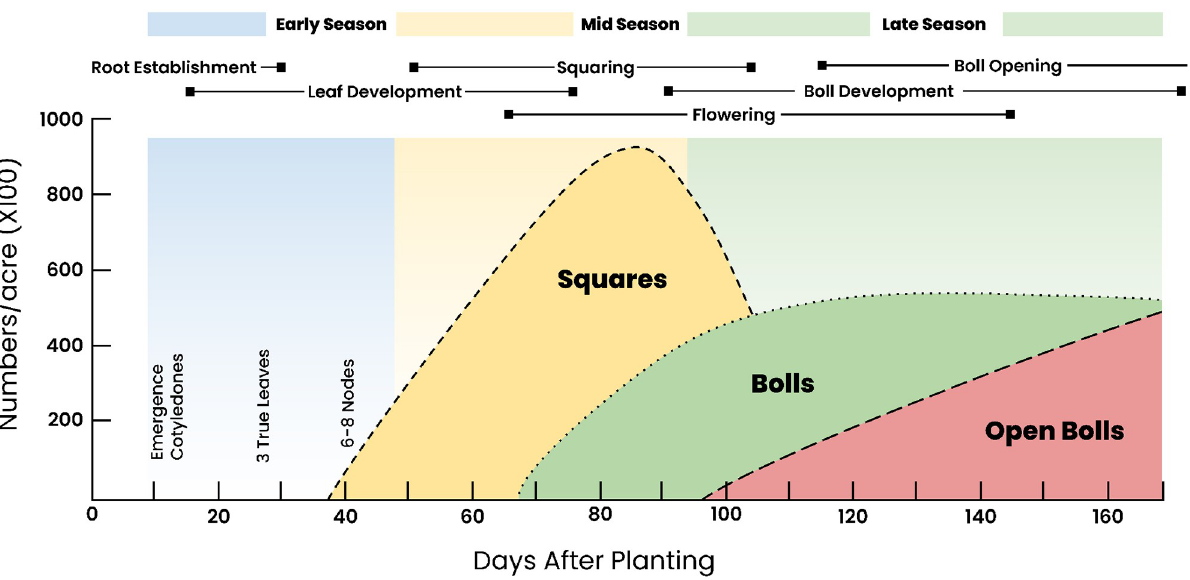
Fig 1. The phenological cycle of cotton in Greece. The principal phenological stages of cotton are Root Establishment (RE), Leaf Development (LD), Squaring (S), Flowering (F), Boll Development (BD) and Boll Opening (BO). The temporal overlaps between adjacent phenological stages are illustrated. Retrieved from [69] and